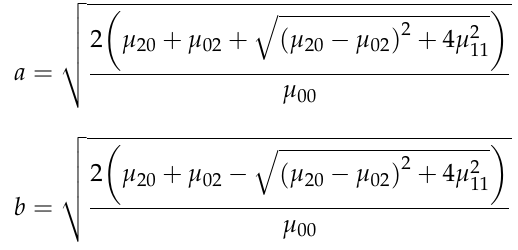
( b ) Figure 5. Segmentation results of impurity in machine-picked seed cotton. ( a ) The original image; ( b ) impurities after segmentation. 2.3. Tested Experiment on the Impurity Content of Mechanically Harvested Seed Cotton 2.3.1. Impurity Detection Based on Image Information After the machine-picked seed cotton images were collected, SVM image segmenta- tion, k-means clustering segmentation and multi-channel fusion segmentation were used, respectively. Using the ratio of the total pixel area of impurities to the total pixel area of the entire image, the final impurity rate is obtained. The specific calculation formula is defined as follows: